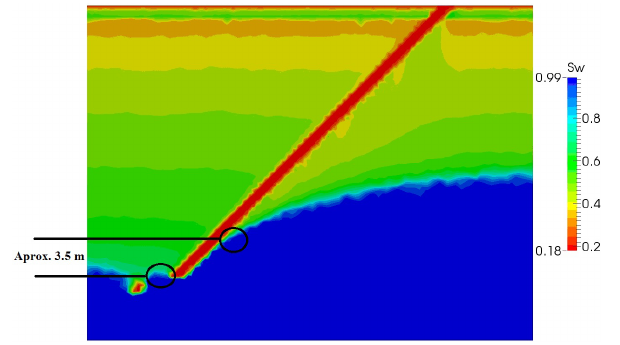
Figure 4. Water saturation in the case of a single well extraction with a fault